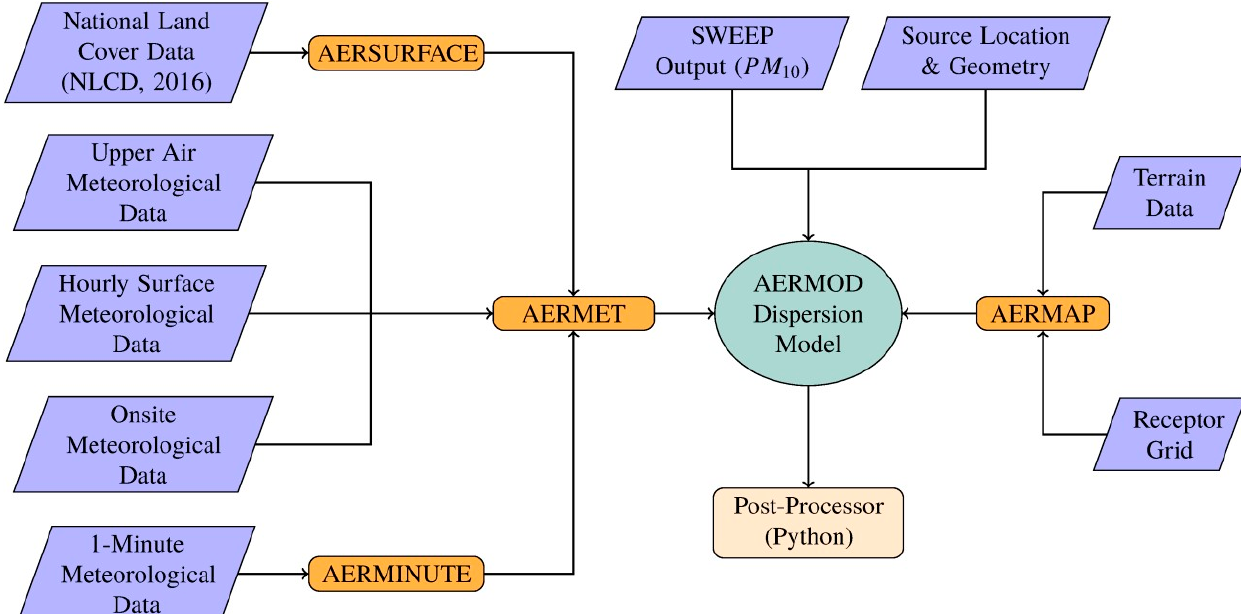
Figure 7. AERMOD modeling system. AERMOD accompanies two data preprocessors that are regu- latory components, the AERMET and AERMAP models. Other non-regulatory components include AERSURFACE, a surface characteristics preprocessor model; AERMINUTE, a 1-min Automated Surface Observing Stations (ASOS) wind data processor; pollutant source parameters (loca- tion and geometry); and pollutant emission rate (derived from the SWEEP outputs).